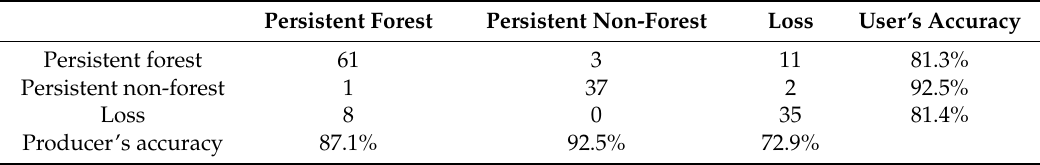
Table 5. Forest change validation; 2000–2014. Validation was done using 2000–2014 annual NDVI forest change dataset derived from points visually interpreted using Landsat and high-resolution imagery. If areas classified as forest in 2000 showed decreases in NDVI values during adjacent year periods afterwards (e.g., between 2001 and 2002, 2003 and 2004, and so on through 2014), then the change areas were classed as forest loss. Areas that did not show changes in the forested or non-forested areas were classed as persistent forest or persistent non-forest. Overall accuracy using this approach was 84.2%.